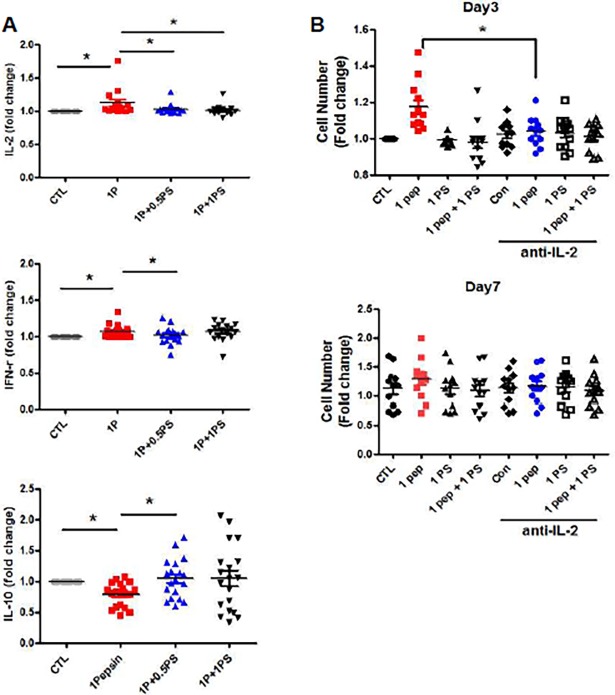
Effect of pepsin on secretion of interleukin-2 (IL-2) and interferon gamma (IFN-γ), and interleukin 10 (IL-10) by CD4-positive cells and anti-pepsin effect of IL-2 blocking.CD4-positive cells were isolated using MACS and treated with pepsin and pepstatin for 7 d. The IL-2, IFN-γ, and IL-10 levels in the culture medium were measured by enzyme-linked immunosorbent assay (ELISA) (A). IL-2 is blocked by IL-2 blocking antibody (anti-IL-2) on day 3 and day 7. The cell number is counted in each treated groups (B). Values represent mean ± SEM. *p < 0.05 (n = 17). 1P, 1.0 μg/ml pepsin; 0.5 PS, 0.5 μg/ml pepstatin; 1 PS, 1.0 μg/ml pepstatin; CTL, no pepsin or pepstatin.